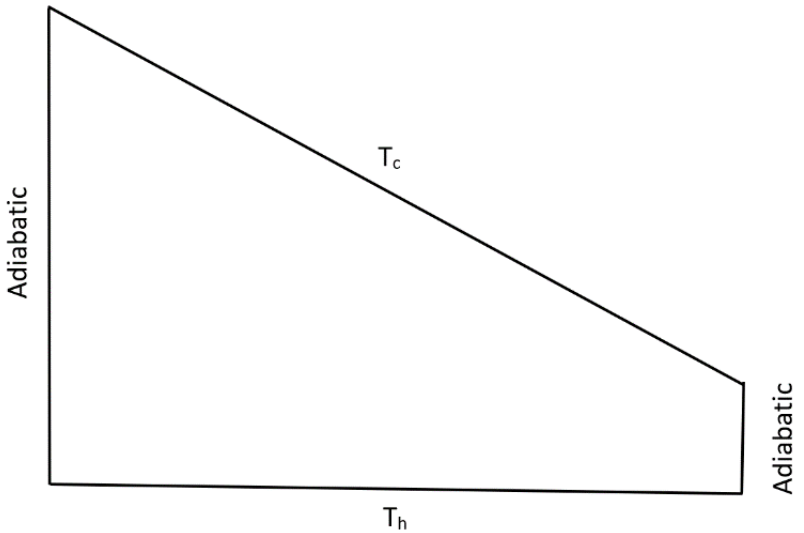
Figure 1. Boundary conditions used in this study.